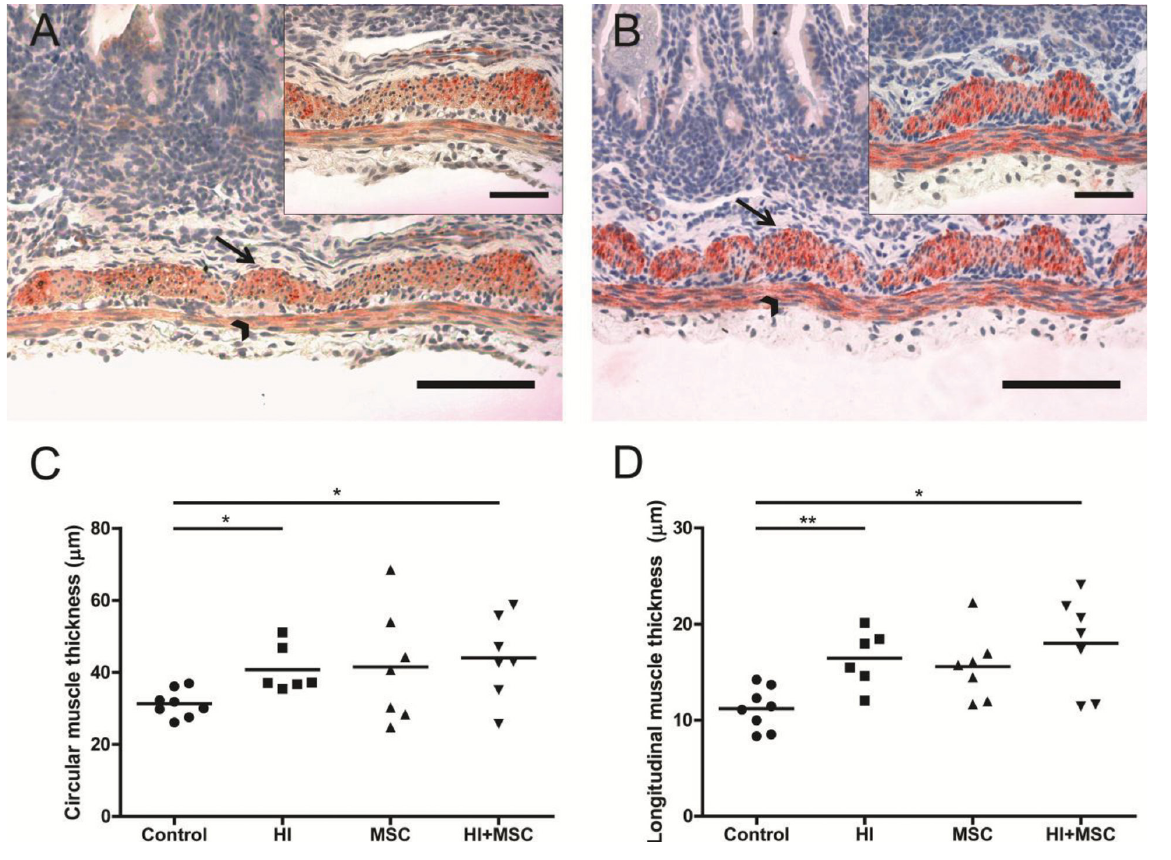
figure 5. Increased thickness of the longitudinal and circular muscle layers 7 d after HI. Representative intestinal sections of (A) control and (B) HI animals were stained by immunohistochemistry for SMA22 (red). For each experimental group, muscle thickness in (C) circular (arrow) and (D) longitudinal (arrowhead) muscle layers was measured and the mean thickness per power field per animal is given. The scale bar in panels A and B represents 100 μ m. The scale bar in insets represents 50 μ m. * p < 0.05, ** p <